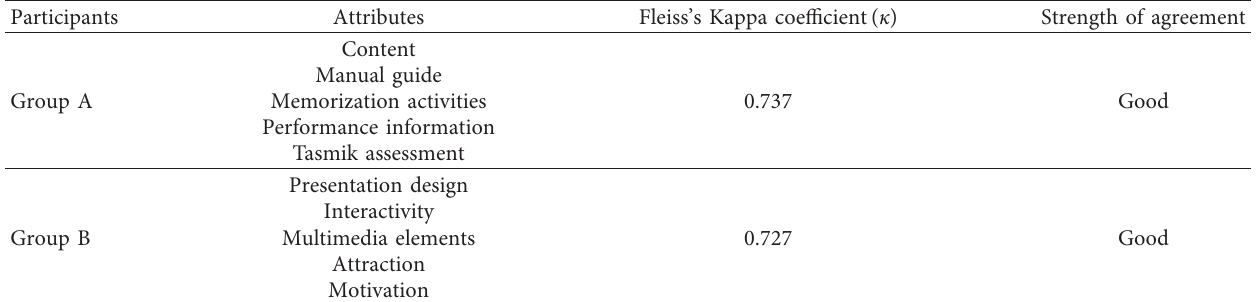
Table 5: Data analysis of heuristic